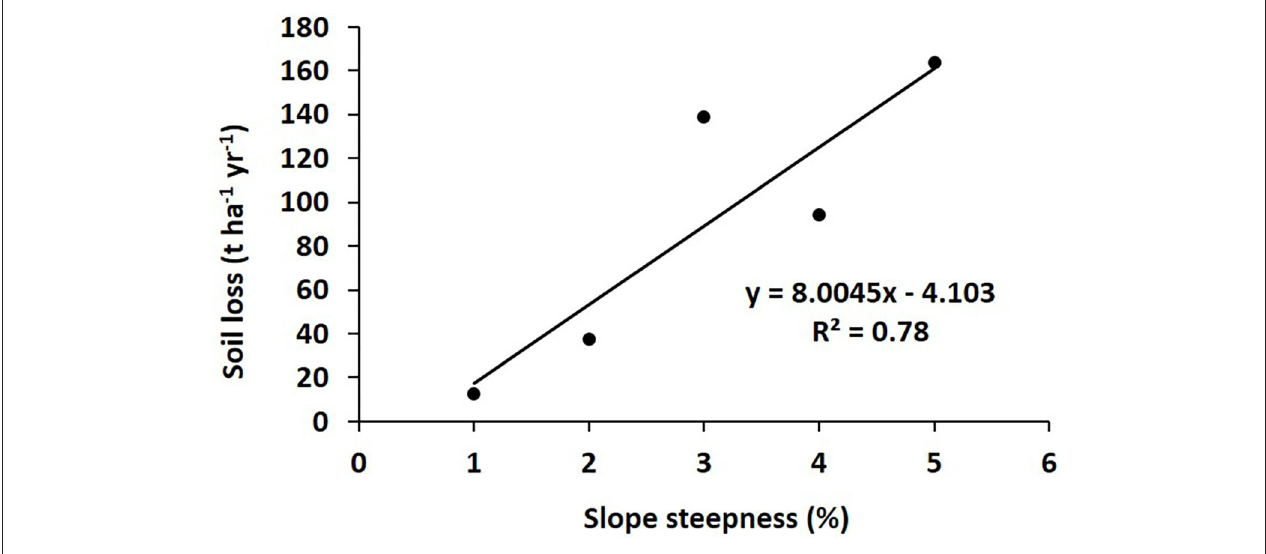
FIGURE 2 | Effect of slope steepness on soil loss.